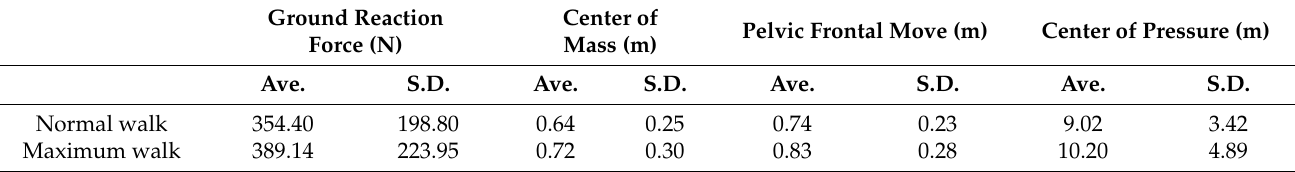
Table 4. Comparison of balance factor during the normal walking and fast walking of the elderly. Ground